Question: What does this figure show? Answer in one sentence.
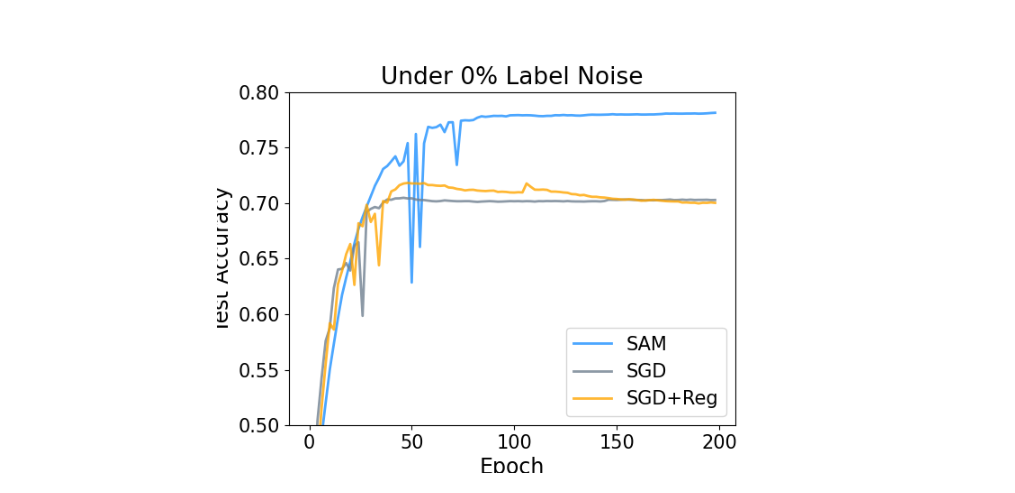
Answer: SAM (ρ = 0.01) and SGD have a smaller 8% difference in performance (less in compar- ison to the 20% difference with 30% label noise). Our weight and feature norm penalty observes improvements but only by a small factor of 1% and the performance degrades over time.